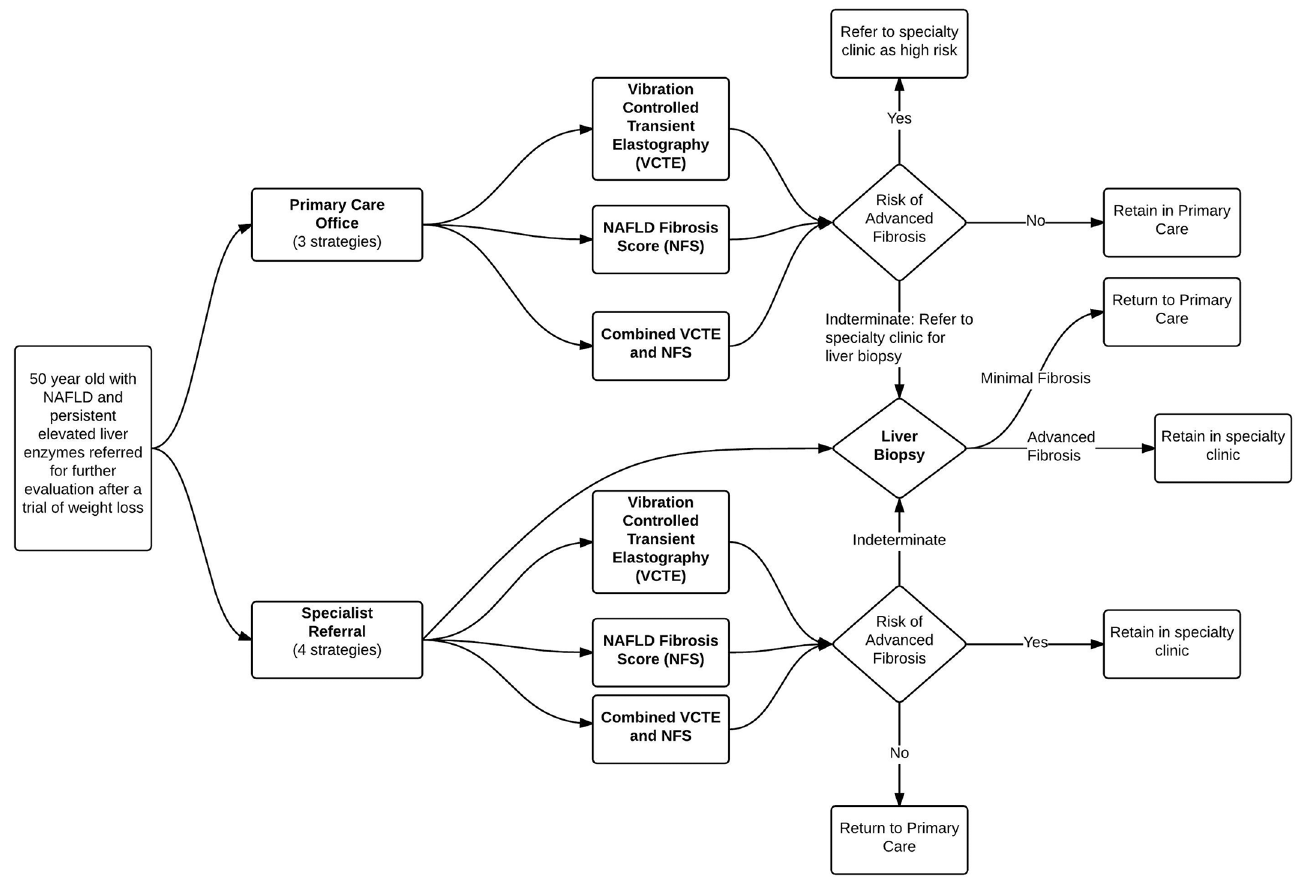
Fig 1. Flowchart of Patient Evaluation By